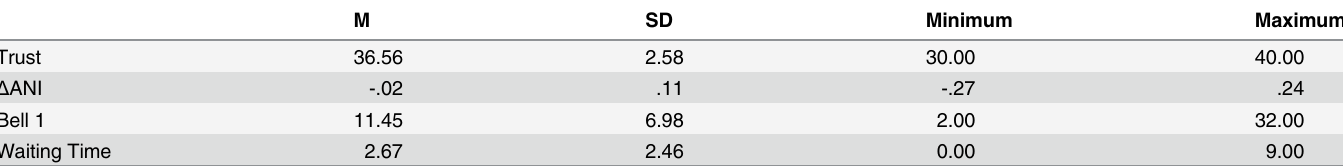
Table 1. Descriptive statistics.